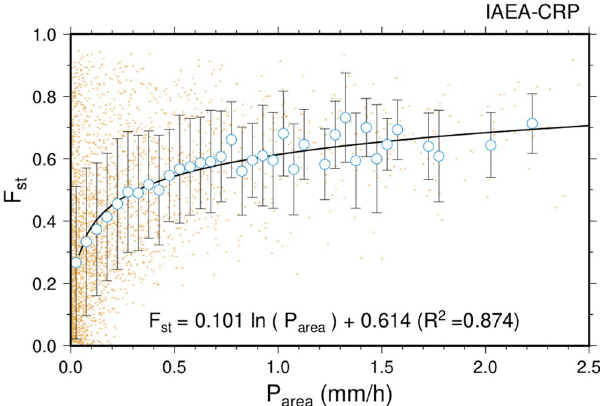
Figure 2. Relationship between stratiform rainfall area fraction (F st ) and the area-averaged rainfall amount (P area ) over the 5° × 5° longitude/latitude box centred on each station during the period where rainfall was sampled for isotopic analysis. Orange dots represent each individual data. Blue circles with error bars represent the average and standard deviation in precipitation intensity bins for each 0.05 mm/h interval up to 1.5 mm/h. Solid curved line shows a logarithmic regression of averaged